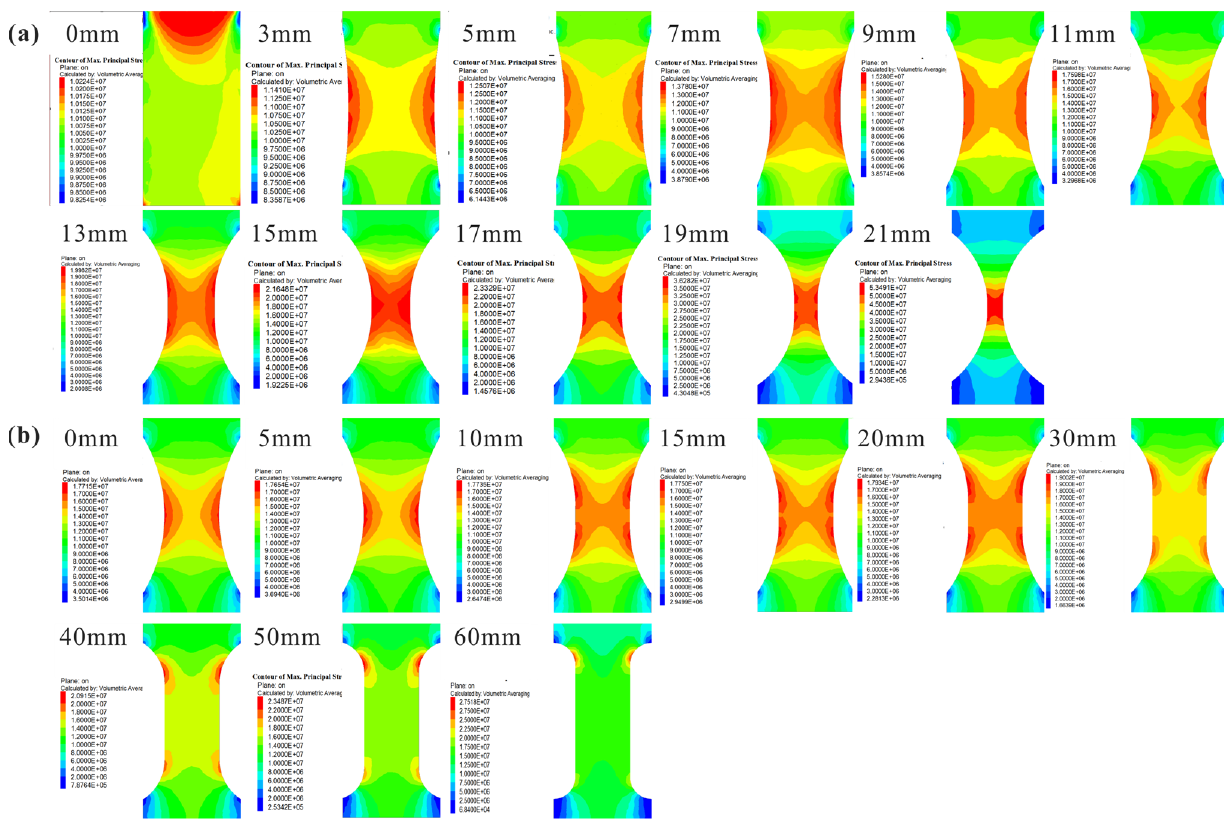
Figure 2. Maximum principal stress contours of the flattened cylinder specimens in yoz section plane ( a ) with different cutting thicknesses t ( t = 0, 3, 5, 7, 9, 11, 13, 15, 17, 19, 21 mm) for a given flat length l ( l = 10 mm) ( b ) with different flat lengths l ( l = 0, 5, 10, 15, 20, 30, 40, 50, 60 mm) for a given cutting thickness t ( t = 10